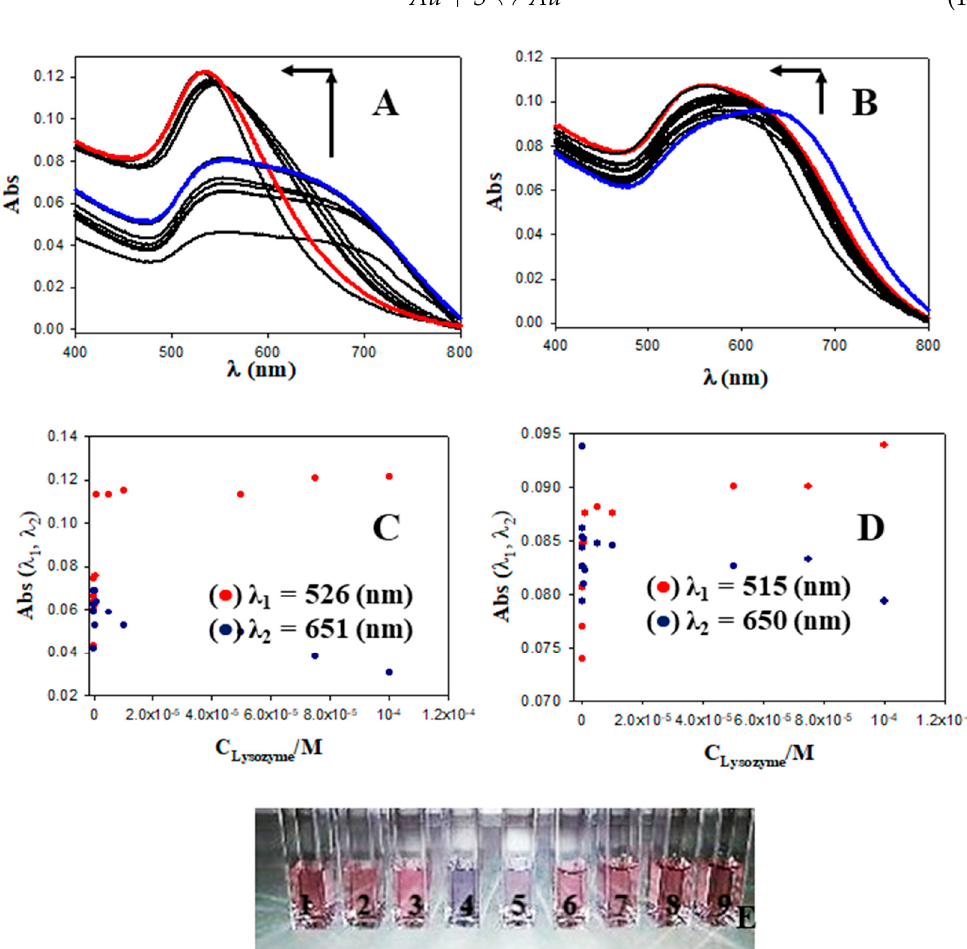
Figure 6. Absorbance titration of aggregated Au@16-s-16/SDS systems at different C Lysozyme concentrations (addition method A). ( A , B ) C Lysozyme = 0 µ M (blue spectrum), C Lysozyme = 100 µ M (red spectrum), C Lysozyme = 0.001, 0.005, 0.01, 0.05, 0.50, 0.65, 1.00, 5.00, 10.0, 50.0 and 75.0 and 100.0 µ M (black spectrum, arrow direction). ( C , D ) Absorbance versus C Lyzozyme , red (nonaggregated nanoparticles) and blue points (aggregated nanoparticles) correspond to absorbance data at fixed wavelength. ( E ) Detailed view of corresponding color changes for Au@16-3-16/SDS/Lysozyme system. (1) C Lysozyme = 0 µM, (2) C Lysozyme = 0.001, (3) C Lysozyme = 0.005, (4) C Lysozyme = 0.05, (5) C Lysozyme = 1.0 µM, (6) C Lysozyme =